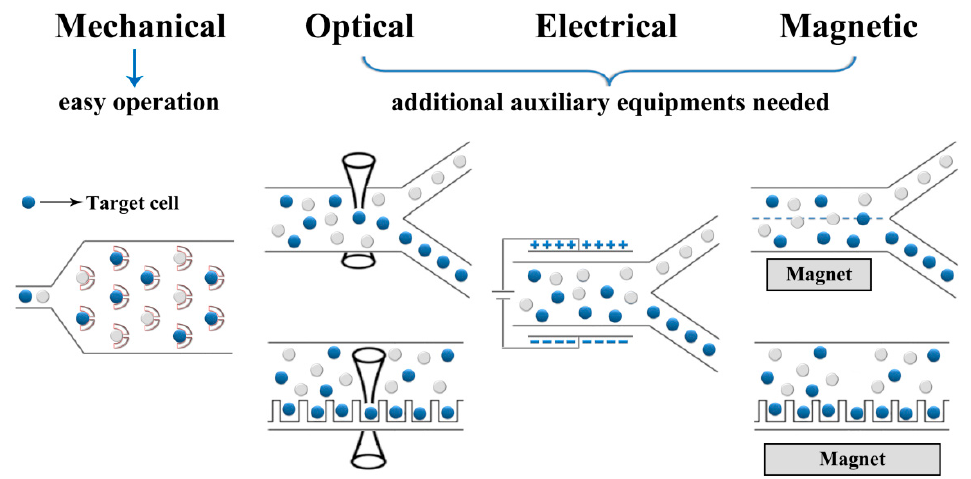
Figure 2. Illustrative schematics of mechanical, electrical, optical, and magnetic methods in cell manipulation techniques.